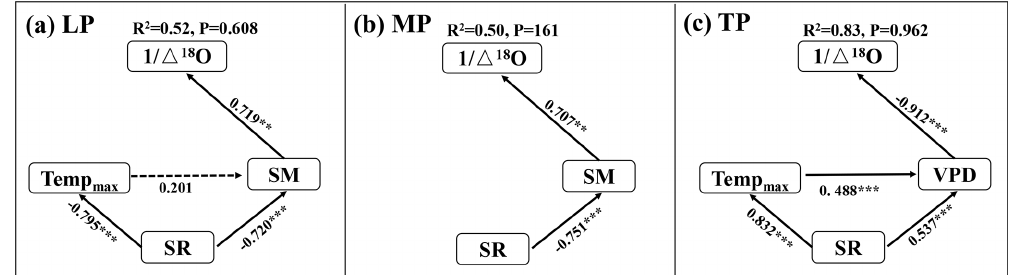
Figure 4. Structural equation models of abiotic factors explaining community 1 /(cid:49) 18 O on the Loess Plateau (LP) (a) , the Inner Mongolian Plateau (MP) (b) , and the Tibetan Plateau (TP) (c) . The variables mentioned in the figure are as follows: (cid:49) 18 O – 18 O enrichment above the source water of leaf organic matter, Temp max – maximum temperature, SR – solar radiation, SM – soil moisture, and VPD – vapor pressure deficit. The solid and dashed arrows represent significant and non-significant relationships in a fitted SEM, respectively. “ ∗∗∗ ” denotes P< 0 . 001, “ ∗∗ ” denotes P< 0 . 01, and “ ∗ ” denotes P< 0 . 05.